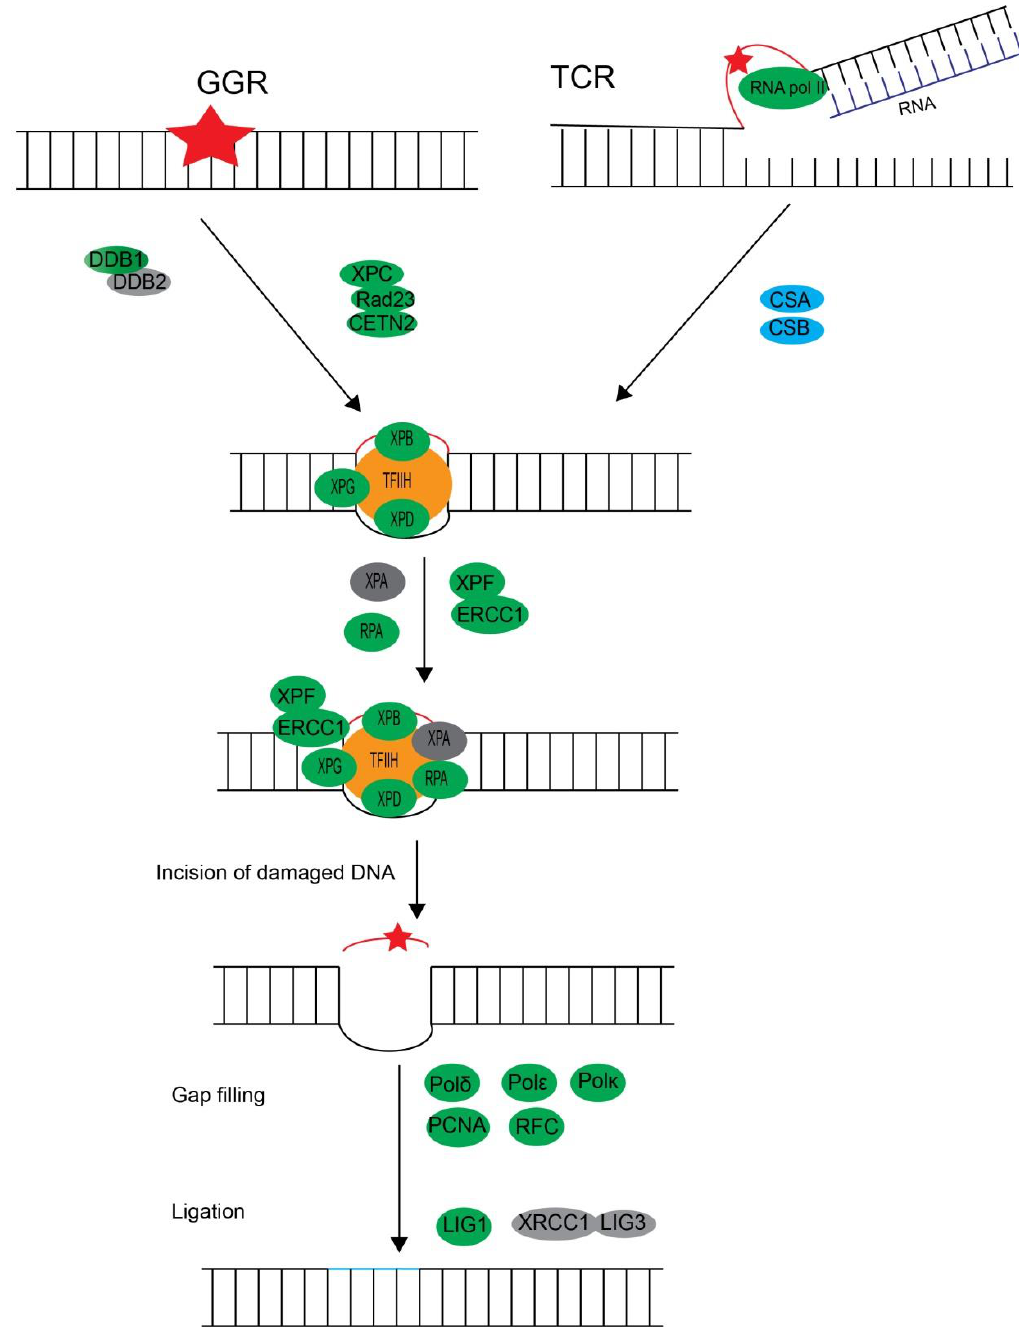
Figure 4. Diagrammatic summary of the dinoflagellate orthologues predicted in the nucleotide excision repair pathway. The ellipses filled with grey color mean the absence of putative dinoflagellate orthologues in the searched transcriptomes. The other colors in ellipses indicate the presence of putative dinoflagellate orthologues.